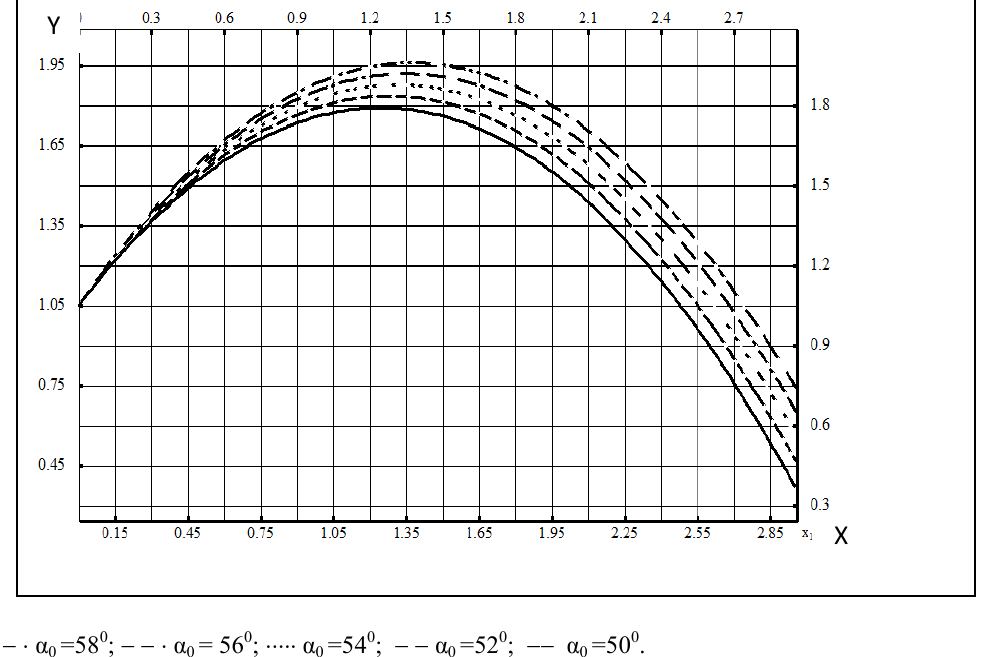
Fig.4. Characteristic curves of masses center trajectories for different values of takeoff